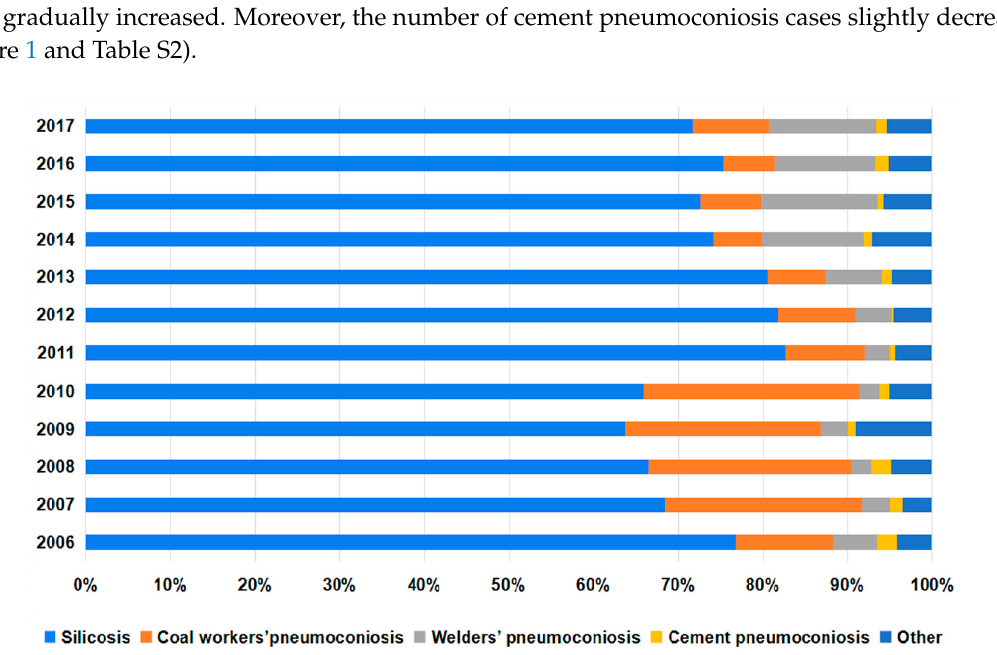
Figure 1. The changes in the number of pneumoconiosis cases reported from 2006 to 2017.